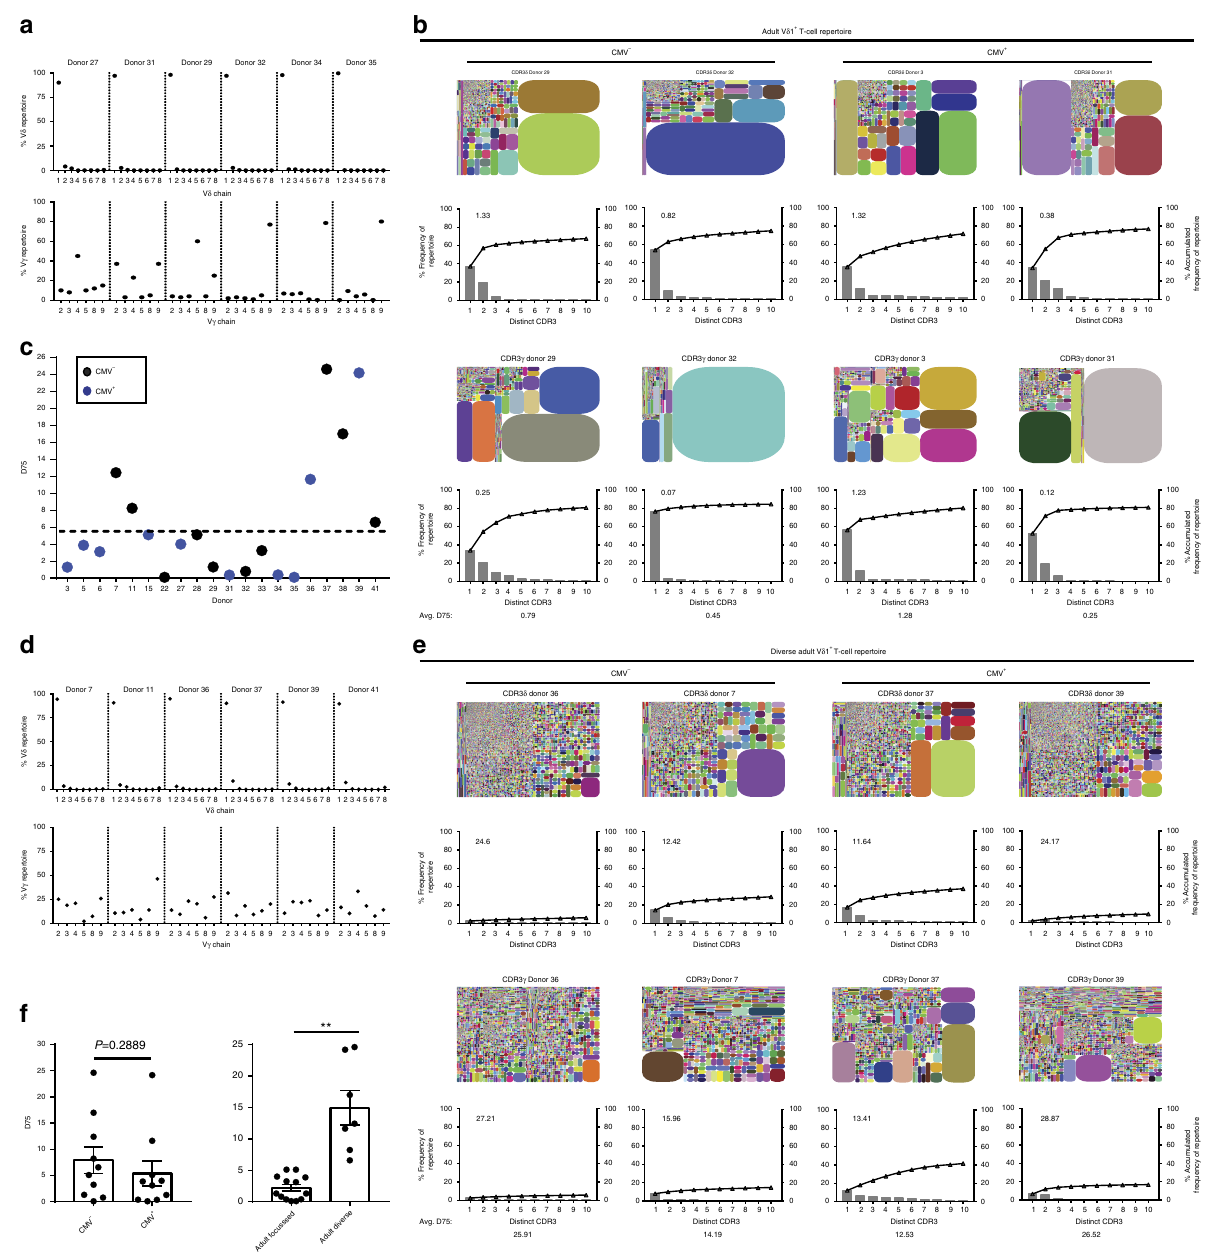
Figure 2 | The V d 1 þ TCR repertoire is focused on a few dominant clonotypes in healthy adults. ( a ) V g and V d chain usage by gd TCR sequences from sorted V d 1 þ Tcells from peripheral blood. Graphs show six representative donors of 13. ( b ) Tree maps show CDR3 clonotype usage in relation to repertoire size (each CDR3 colour is chosen randomly and does not match between plots) and graphs show the individual clone frequency (left y axis) and the accumulated frequency for the first 10 most prevalent clonotypes (right y axis). ( c ) Analysis of inter-donor diversity by D75 (percentage of clonotypes required to occupy 75% of the total TCR repertoire) from TCR d repertoire analyses from 20 donors with CMV-seropositive (blue dots), CMV-seronegative individuals (black dots) and lowest quartile range plotted (dashed line). ( d ) V g and V d chain usage and ( e ) Tree maps and accumulated frequency graphs, for gd TCR repertoires in donors with a D75 4 6. ( f ) Comparison of mean ± s.e.m. of TCR d D75 values for 10 CMV-seropositive and 10 CMV-seronegative donors (Left) and focused donors ( n ¼ 13) against diverse donors ( n ¼ 7) (Right). Data were analysed by student’s t -test, ** P ¼